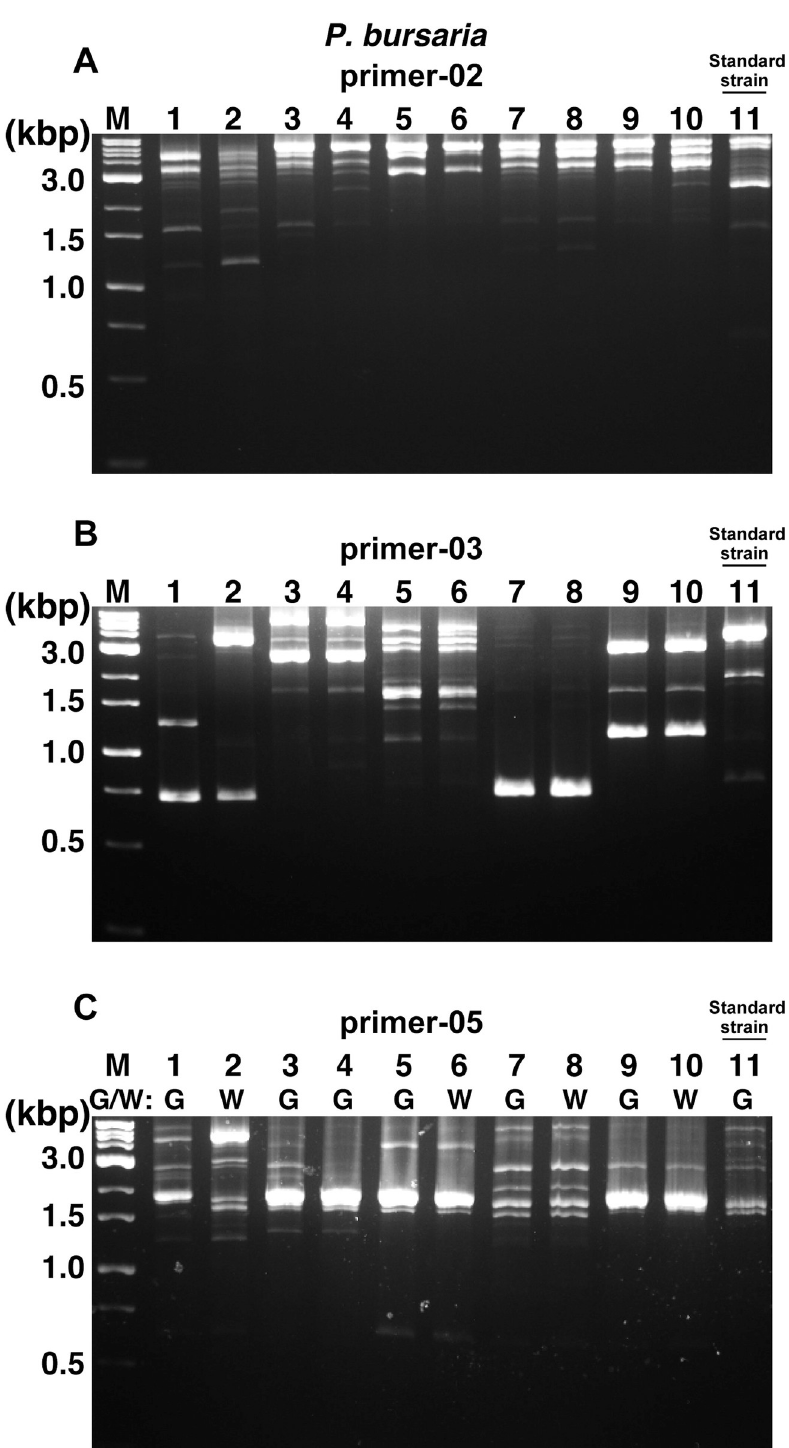
Fig 3. RAPD analysis using template DNA from P . bursaria strains. RAPD analysis using template DNA from 10 recommended strains (Nos. 1–10) and a standard strain (No. 11) of P . bursaria . G, strain with Chlorella . W, strain without Chlorella . The random primers used in each reaction are presented at the top of the figures (A, primer-02. B, primer-03. C, primer-05). M, weight marker.